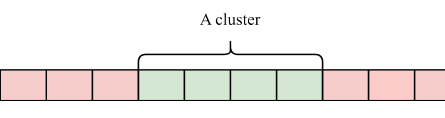
Figure 3. Illustration of division of